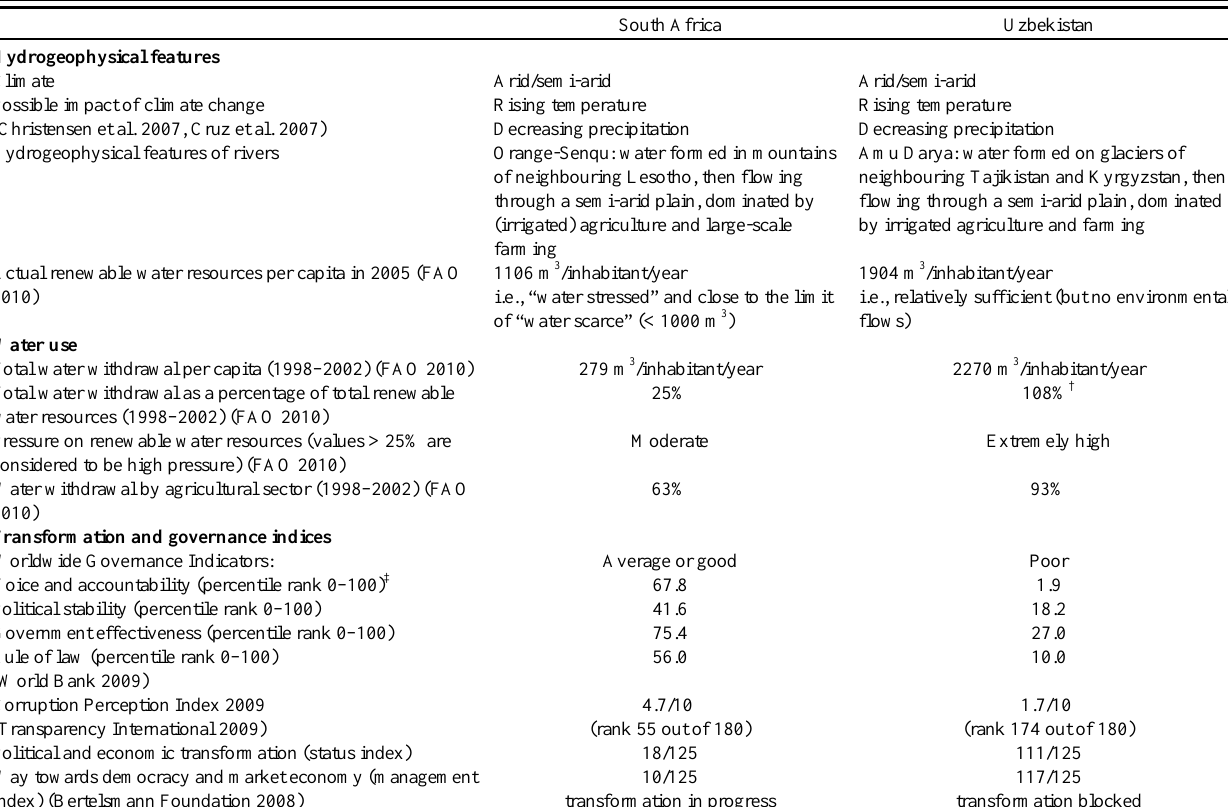
Table 1 . Basic features of the case